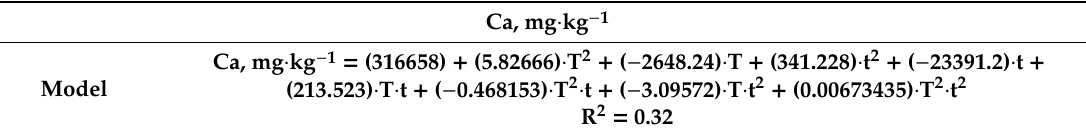
Table A16. The statistical parameters of polynomial regression analysis of the influence of SS torrefaction temperature and residence time on the Ca content in biochars.